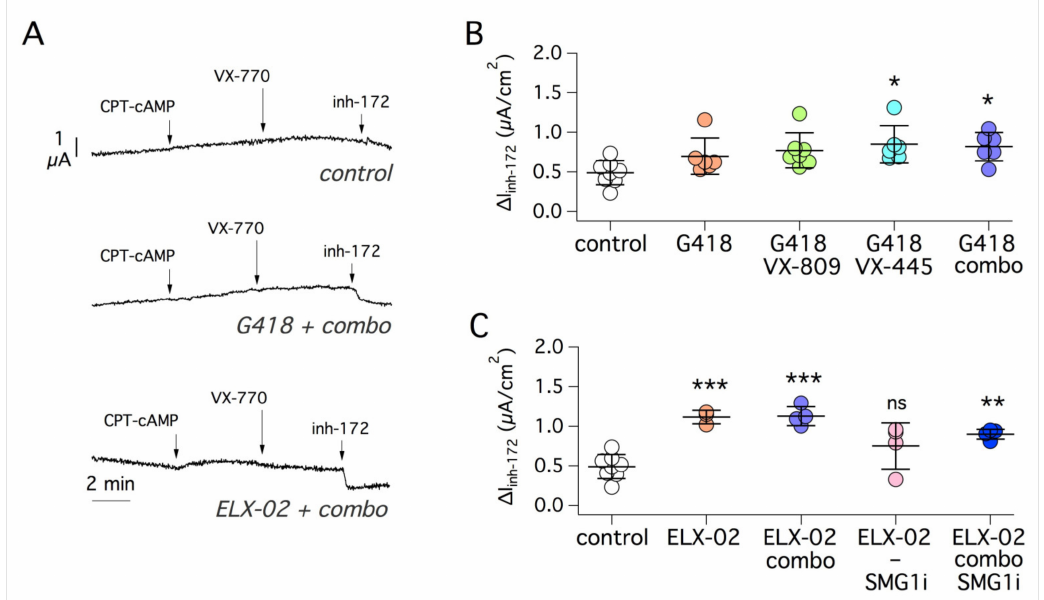
Figure 4. Pharmacological rescue of R553X-CFTR mutant. ( A ) Representative short-circuit current traces from experiments on 16HBE14o- cells expressing R553X-CFTR. ( B , C ) Summary of functional data obtained after treating the cells for 24 h with different combinations of readthrough agents (G418 or ELX-02, 0.5 mg/mL), VX-809 (1 µ M), VX-445 (5 µ M), VX-809 plus VX-445 (combo), and SMG1i (1 µ M). *, p < 0.05 vs. control; **, p < 0.01 vs. control; ***, p < 0.001 vs. control; ns, not significant.